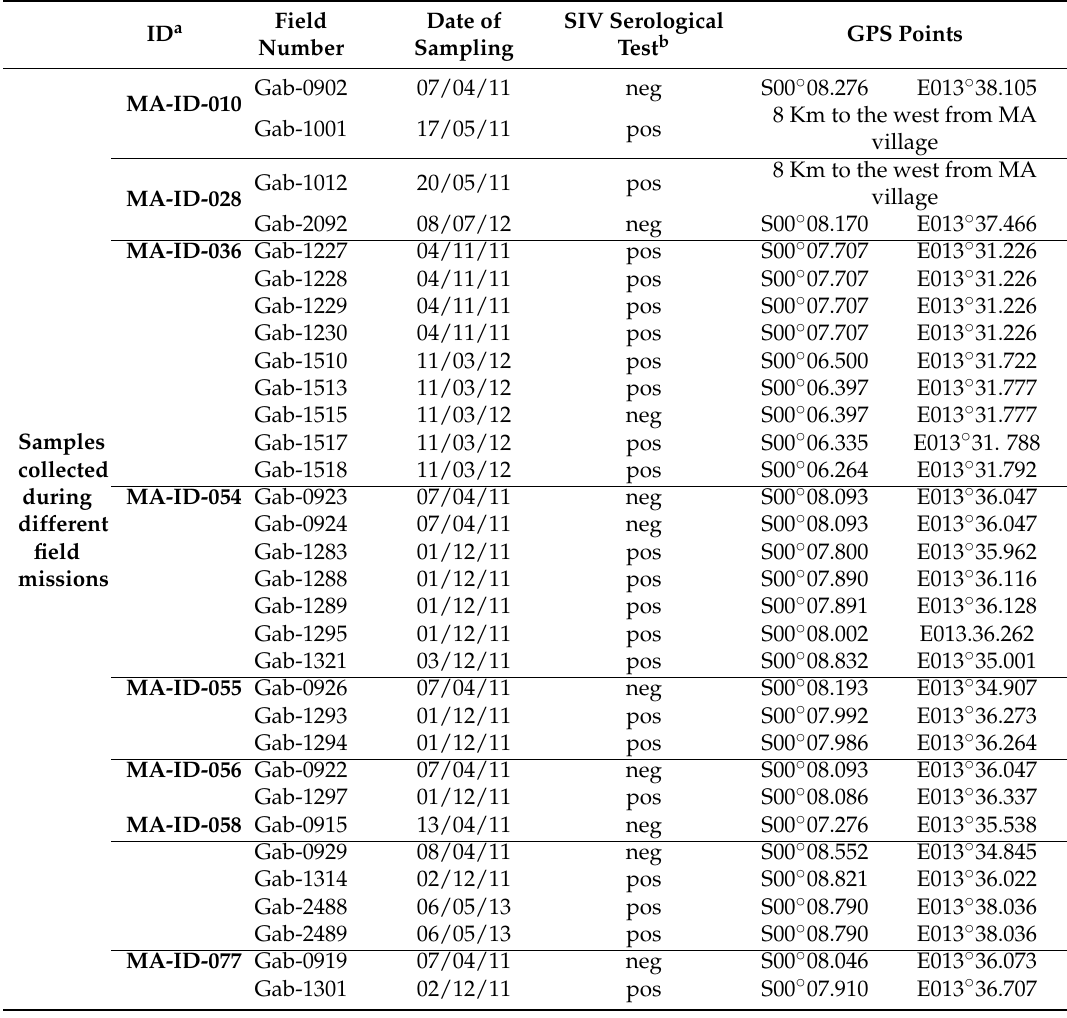
Table 2. Discordant serological test results in samples from the same